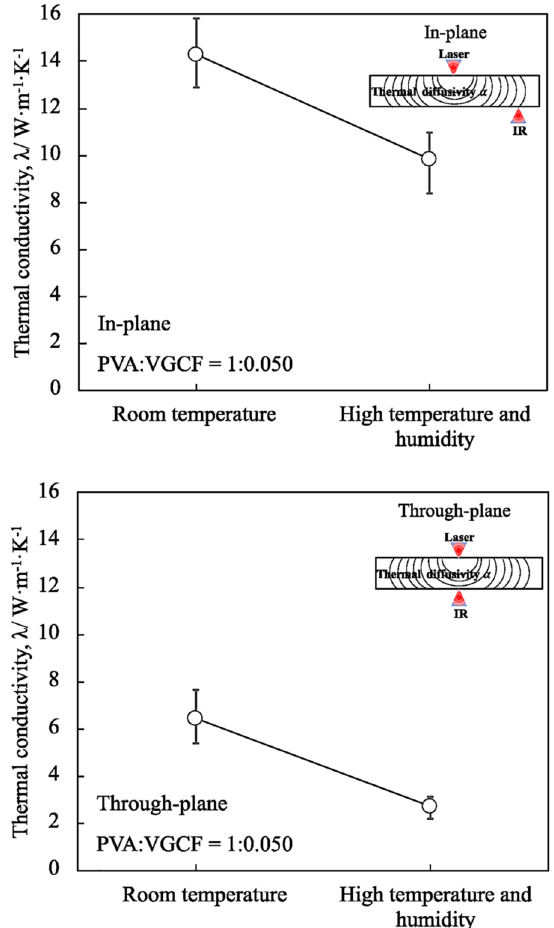
Figure 8. In-plane and through-plane thermal conductivity of specimens before and after the high temperature and humidity